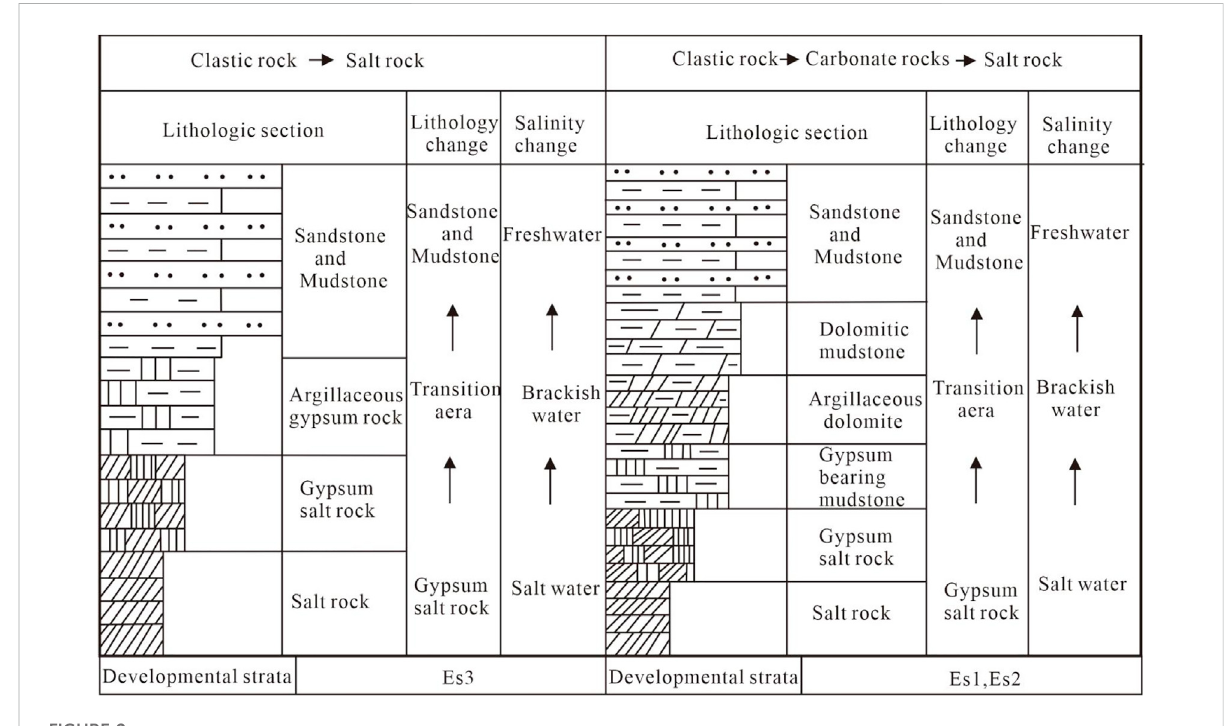
FIGURE 2 Vertical compositions of the gypsum-salt sediment group in Dongpu